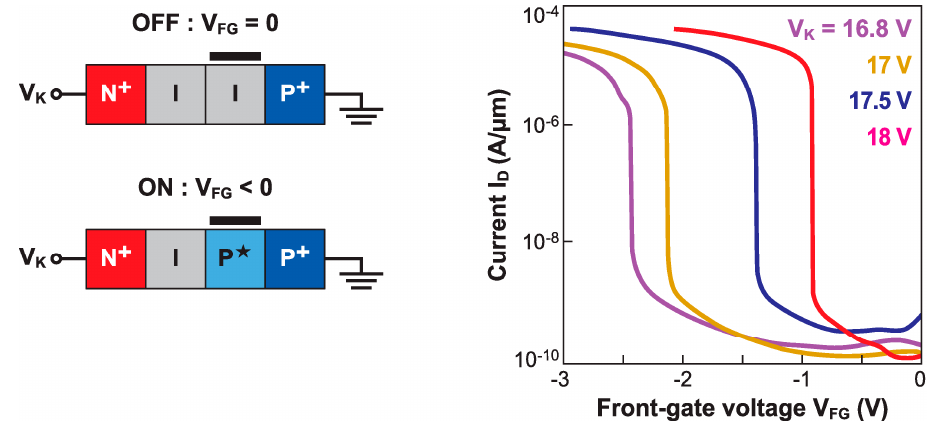
Figure 23. Current vs. gate voltage measured in a P -type I-MOS fabricated on FD-SOI (adapted from [57]).